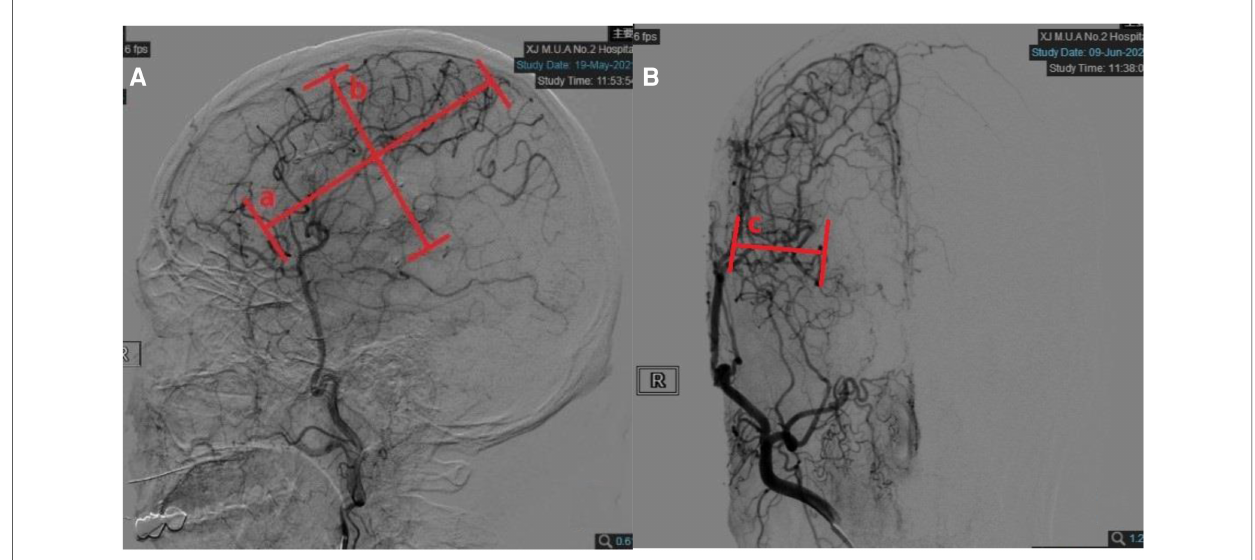
FIGURE 2 Quantitative measurements on follow-up digital subtraction angiography (DSA). ( A ) Measurements taken on the lateral view. Width (line a) was measured as the longest horizontal distance of the area covered by neoangiogenesis. Height (line b) was measured as the longest vertical distance of the area covered by neoangiogenesis. ( B ) Measurements taken on the anteroposterior view. Depth (line c) was measured as the distance between the furthest end of neoangiogenesis and cortical surface in the temporal